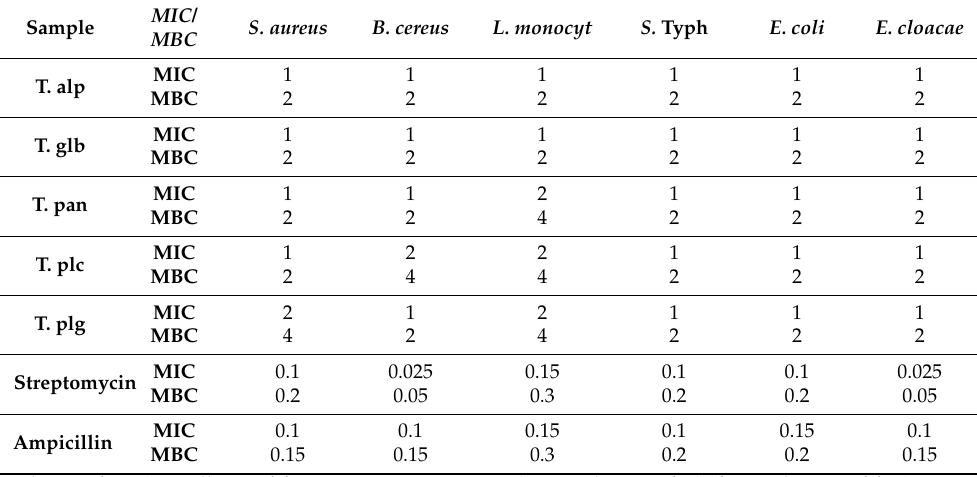
Table 4. Overview of in vitro MICs and MBCs of Thymus extracts.